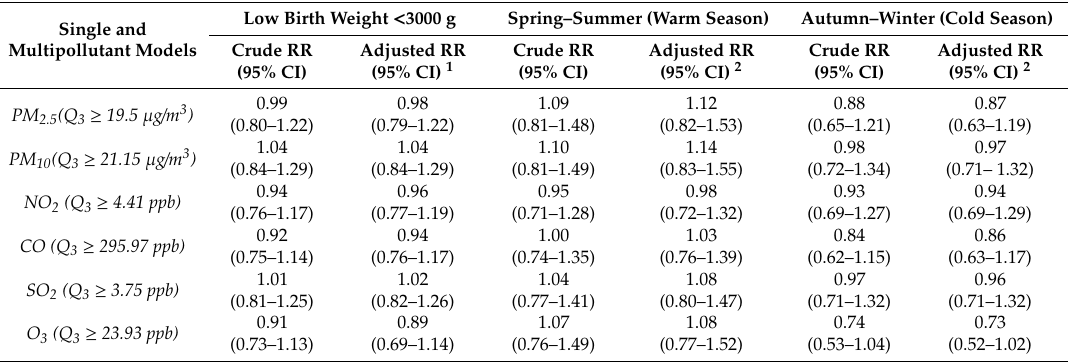
Table A2. The e ff ect of air pollution exposure during entire pregnancy by comparing the exposure levels below and above the median values on low birth weight less than 3000 g (N = 2517), The Espoo